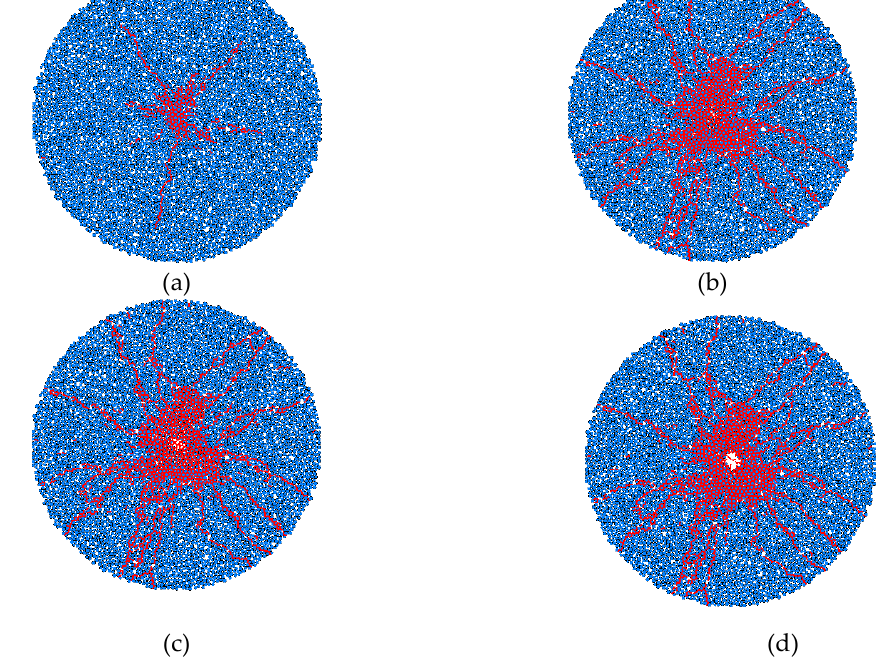
Figure 10. Surface cracking and crack propagation of EPB in granite: (a) t = 80 μs , (b) t = 100 μs , (c) t = 200 μs , and (d) t = 400 μs.